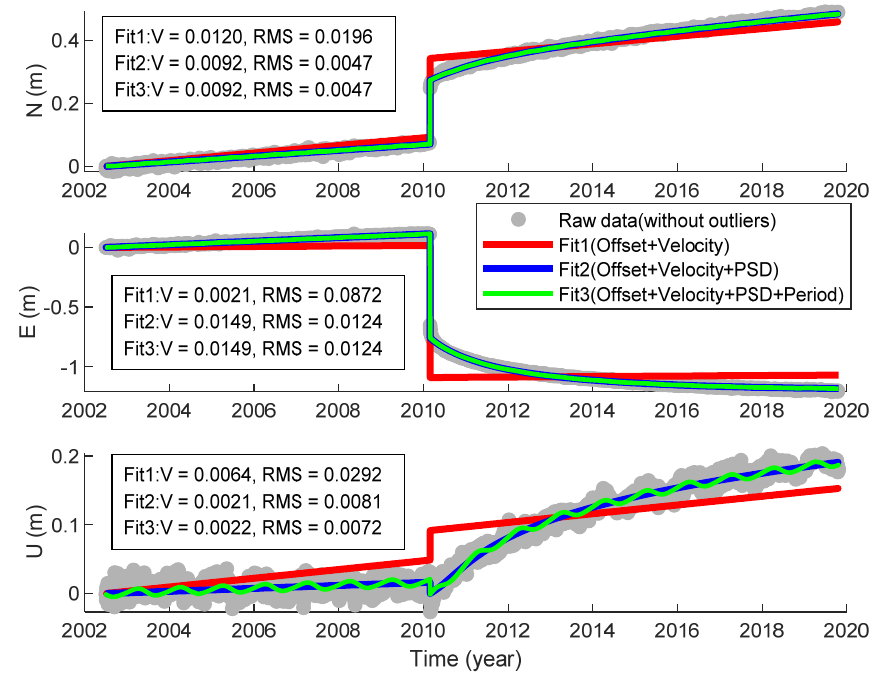
Figure 10. Analysis results of time series fitting models with different combinations (a. Offset + Velocity, b. Offset + Velocity + PSD, c. Offset + Velocity + PSD + Period).